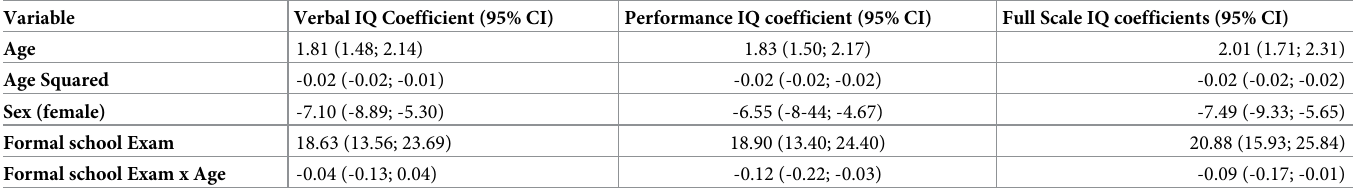
Table 4. Original 50-year participants; coefficients for growth curve models for Verbal-, Performance-, and Full Scale IQ � .